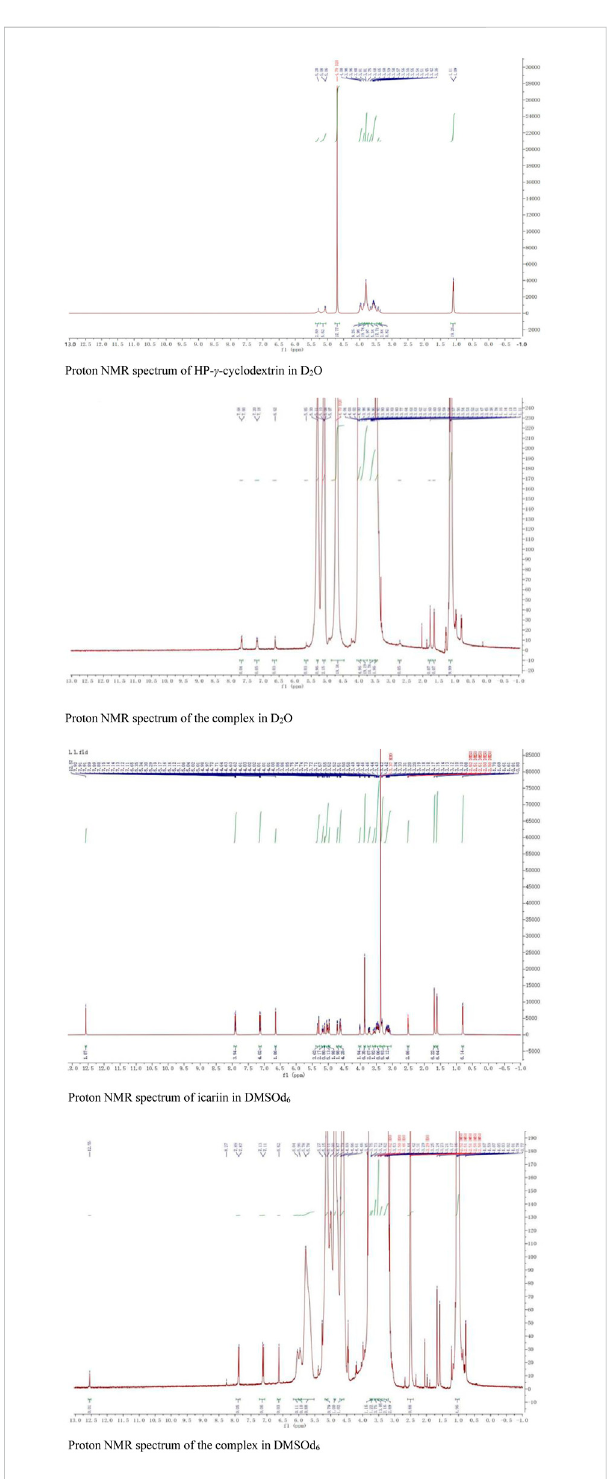
The proton NMR spectra of HP- γ -cyclodextrin and the complex